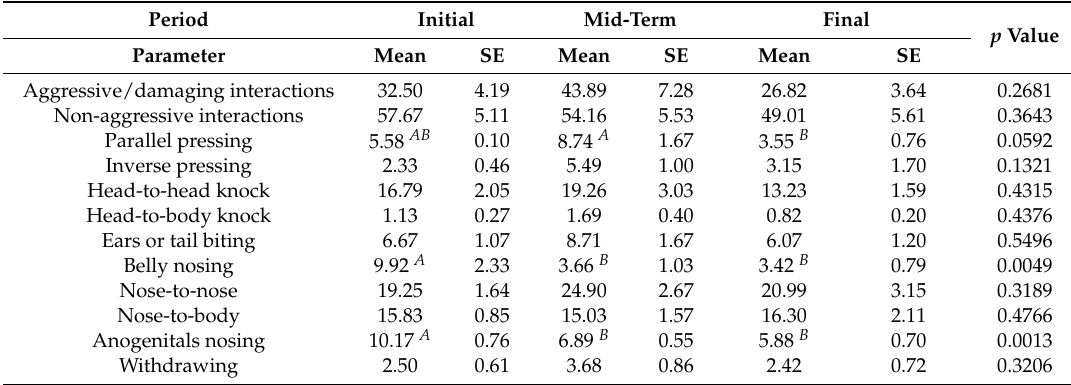
Table 6. Social interaction by period (%).